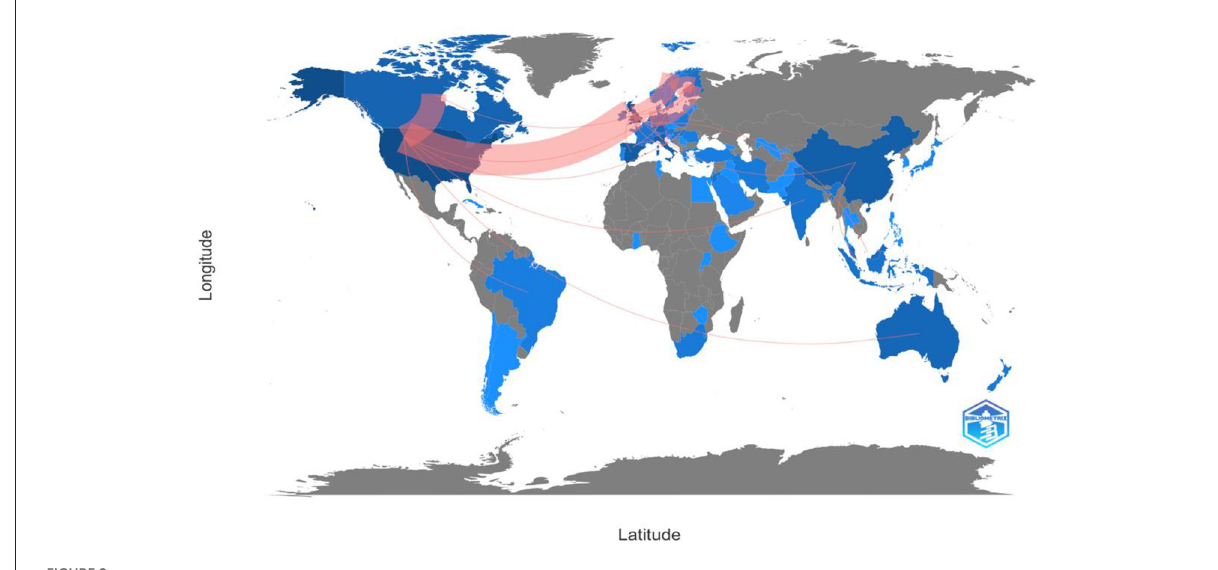
FIGURE2 Collaboration world map of the